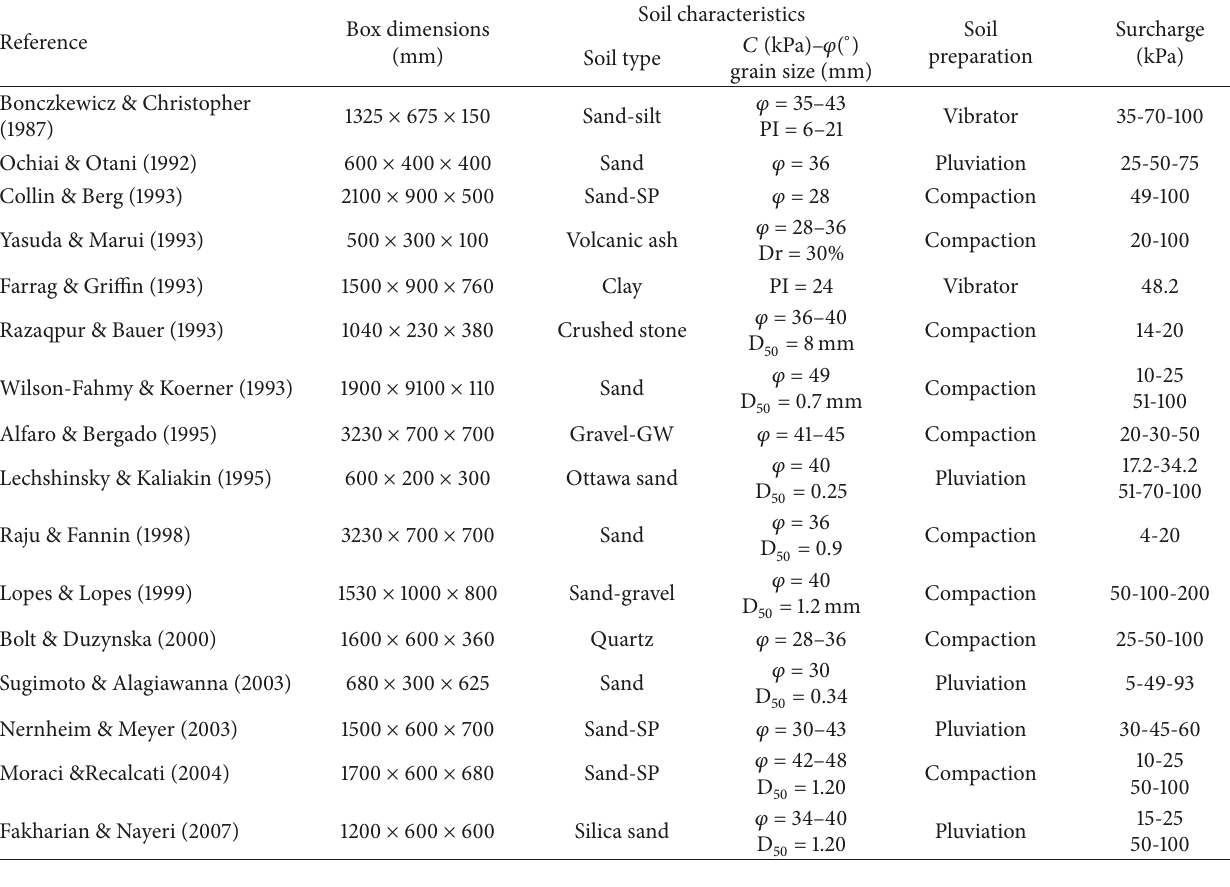
Table 2: Summary of pullout test apparatus and characteristics of materials [22].